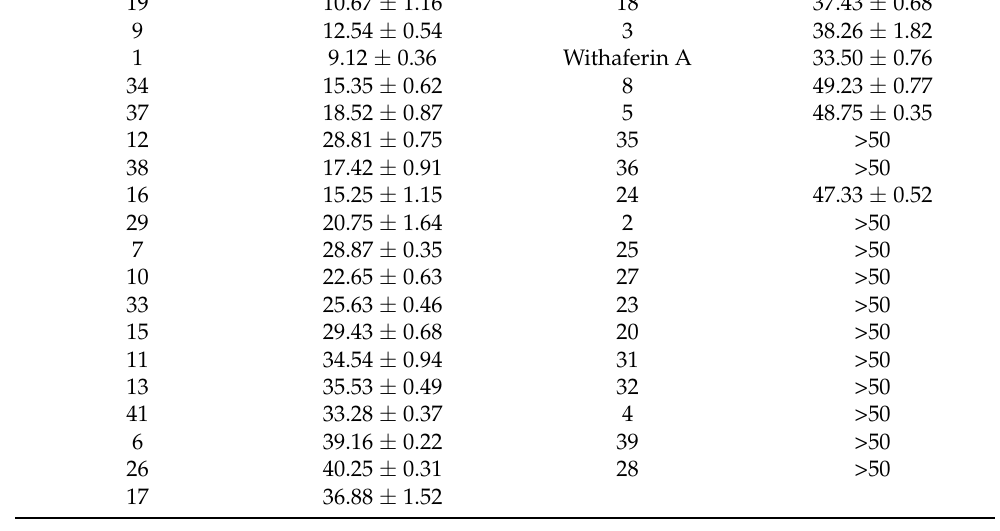
for its significant effect against HepG2 cell lines using mouse xenograft tumor models [32]. According to Liu et al. [33], ursolic acid could suppress HepG2 tumor growth in a time-